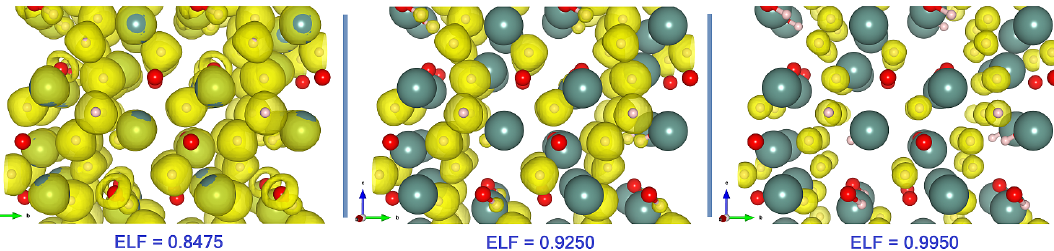
Figure 3. Valence electron localization function (ELF) isosurfaces evaluated for the different values of ELF: These values are given at the bottom of the visualizations. The color codes of the atoms are the same as in Figure 2. The ELF isosurface at ELF = 0.8475 contains the torus-shaped domen typical for the hydroxide